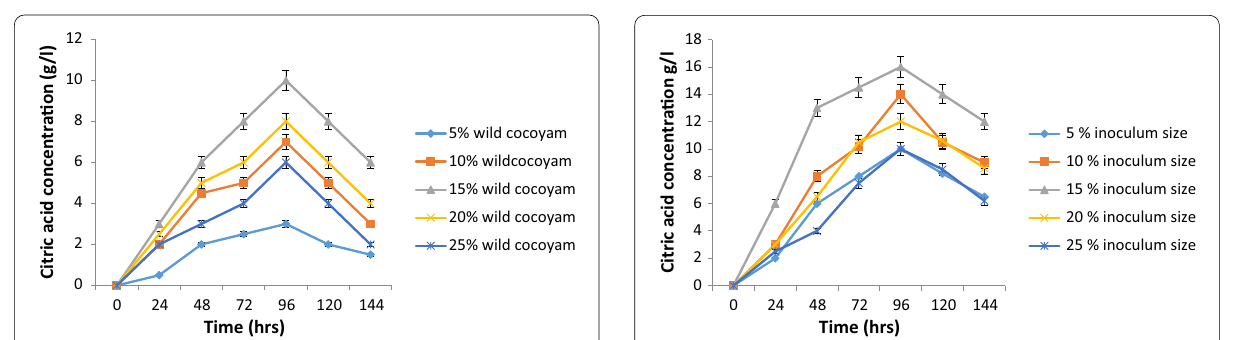
Fig. 3 Effect of inoculum size on citric acid production from wild cocoyam